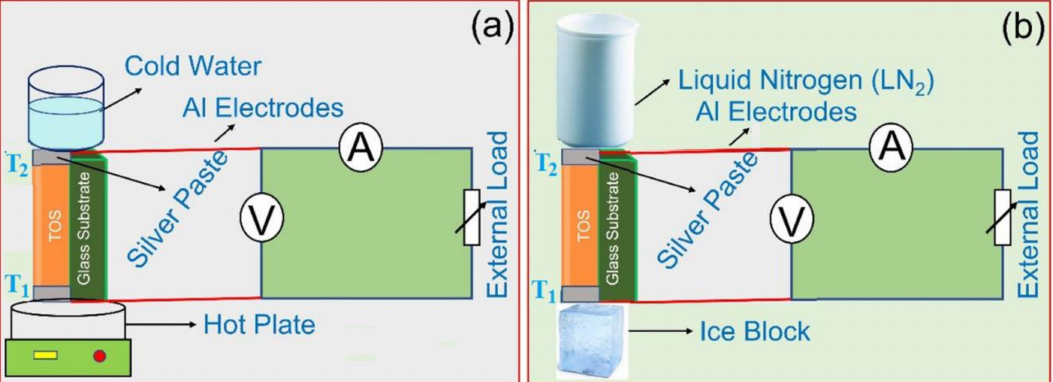
Figure 7. A schematic diagram of the TE device structure and the user setup to measure the power- generation characteristics of a single-leg module of TOS film ( a ) above ( ∆ T = 20 K and 40 K) and ( b ) below RT ( ∆ T = − 20 K and − 40 K).